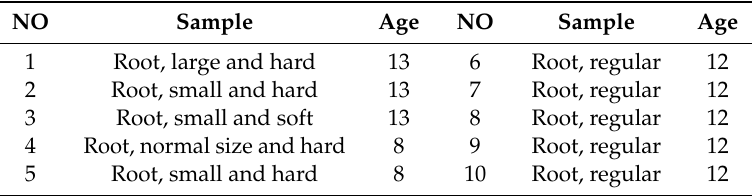
Table 2. Information of ten batches of ginseng